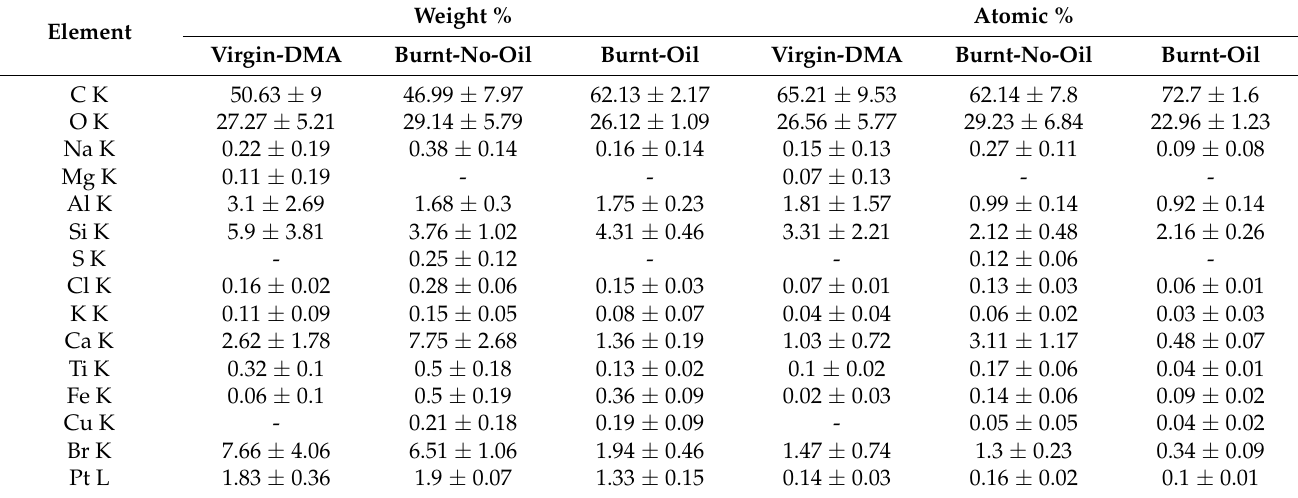
Table A1. Elemental Compositions extracted from the EDS spectra of virgin and deployed E-Glass/Epoxy composite samples. Weight % Atomic % Element Virgin-DMA Burnt-No-Oil